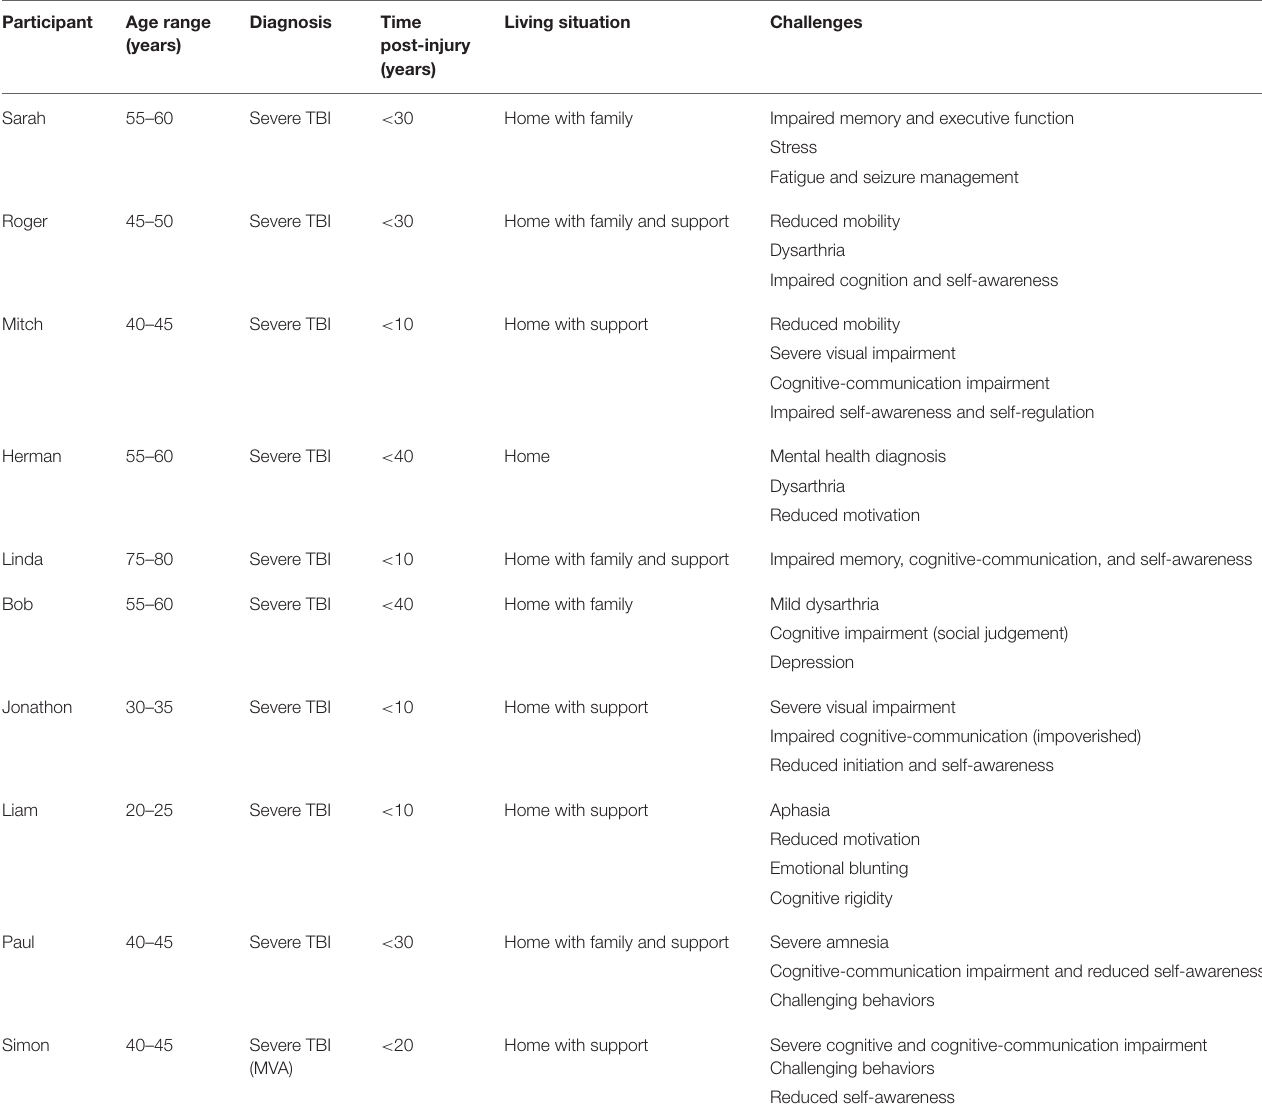
TABLE 1 | Participant